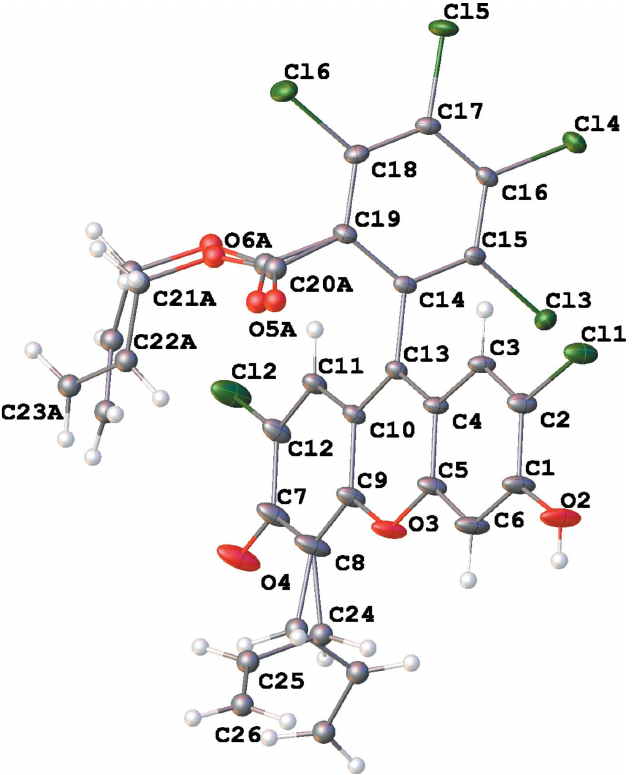
Figure 1 The molecular structure of the title compound with 40% displacement ellipsoids. H atoms as well as atoms of the disordered allyl groups are shown as spheres of arbitrary